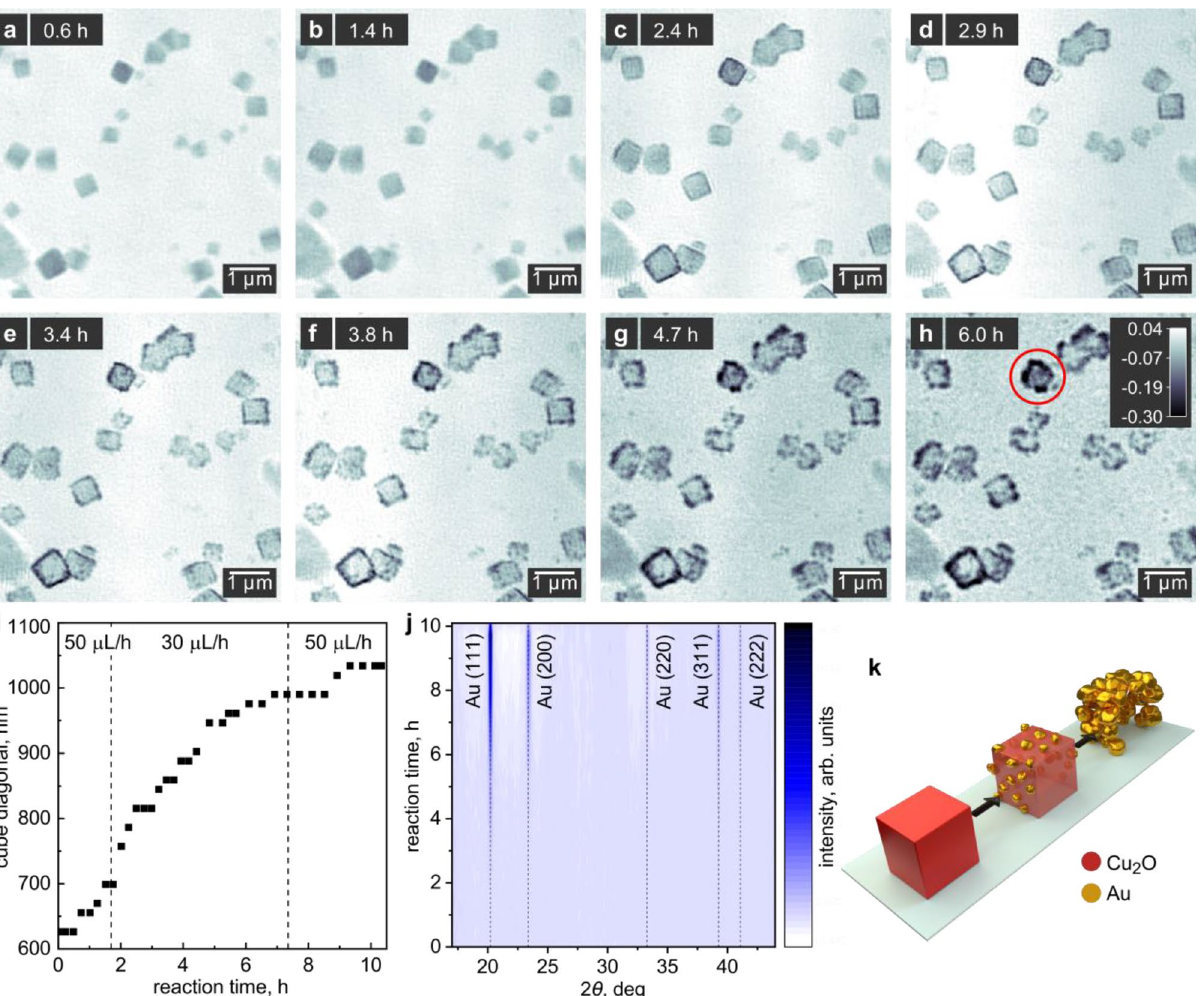
Figure 4. In situ ptychographic images of Au nanocage formation. ( a – h ) Ptychographic images reconstructed after different reaction times while dosing the HAuCl 4 precursor into the reactor. The gray scale indicates the phase shift in radian. ( i ) Size evolution of the nanocube highlighted with a red circle in ( h ). ( j ) Time-resolved XRD patterns obtained alongside the ptychographic images. The reflections of Au become stronger as the replacement proceeds. We observe a significant increase in particle size as Au grains grow at its surface. ( k ) Illustration of the shape evolution during galvanic replacement. While the Cu 2 O in the interior of the nanocages homogeneously dissolved upon oxidation, Au particles nucleate and grow at the surface resulting in porous Au